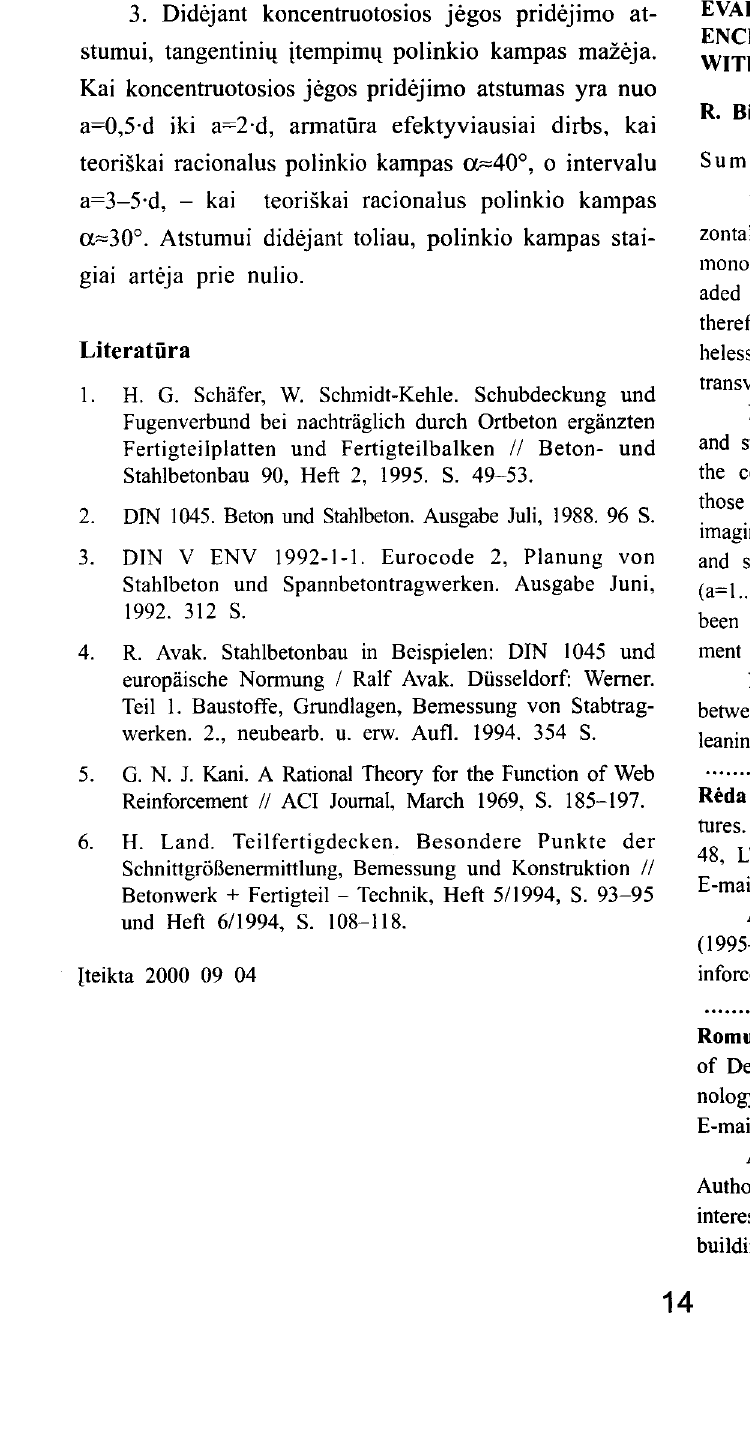
Fig 5. Leaning angle in the support zone of transversal bars with optimal successive shears